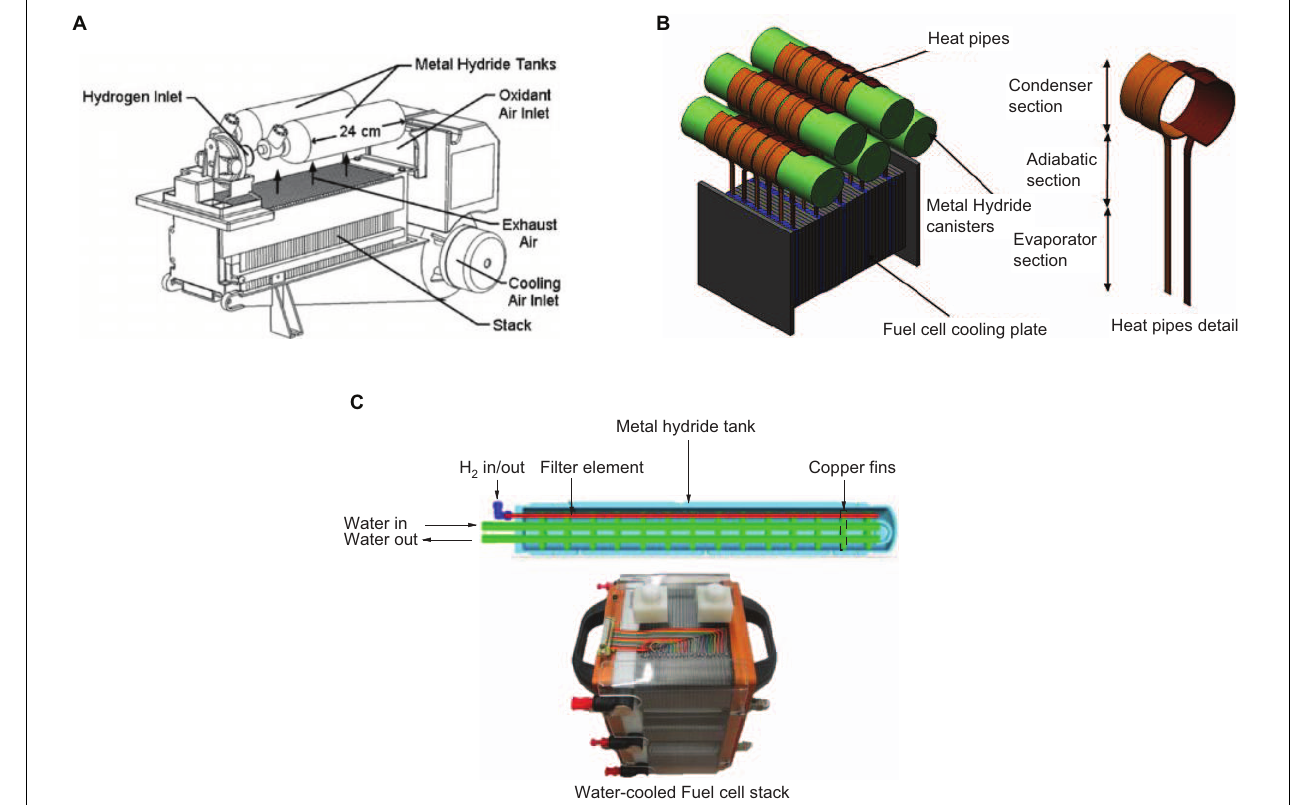
FIGURE 8 | Different thermal integration systems of feeding heat from fuel cell to metal hydride vessel. (A) Exhaust air transmitted via convection system from fuel cell stack (MacDonald and Rowe, 2006), (B) Heat transmitted via conduction system using heat pipes (Tetuko et al., 2016) and (C) Water-heated metal hydride tank using water circulation system from fuel cell stack (Førde et al.,